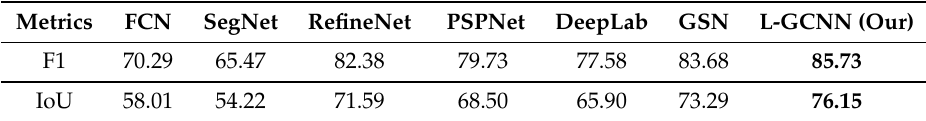
Table 4. Metric scores (%) obtained on Massachusetts Building Dataset. They were measured on the foreground object (the building) for comparison since there were only two categories in this